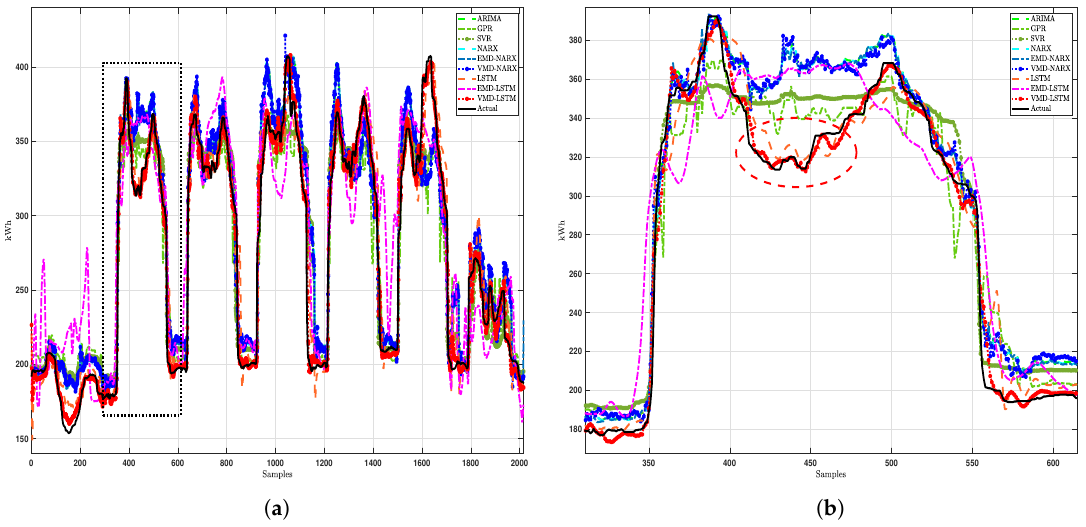
Figure 7. Actual and different load forecasting for a week. ( a ) Weekly load forecasting; ( b ) Monday load